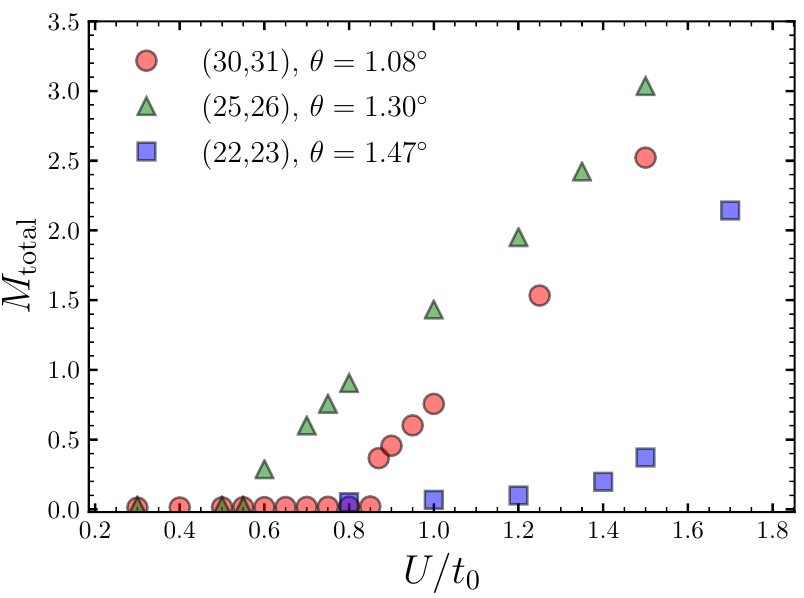
Figure 5: MFT results for the magnetization of the non-scaled twisted bilayer system as a function of U / t at rotation angles θ = 1.08 ◦ , θ = 1.30 ◦ , and θ = 1.47 ◦ , 0